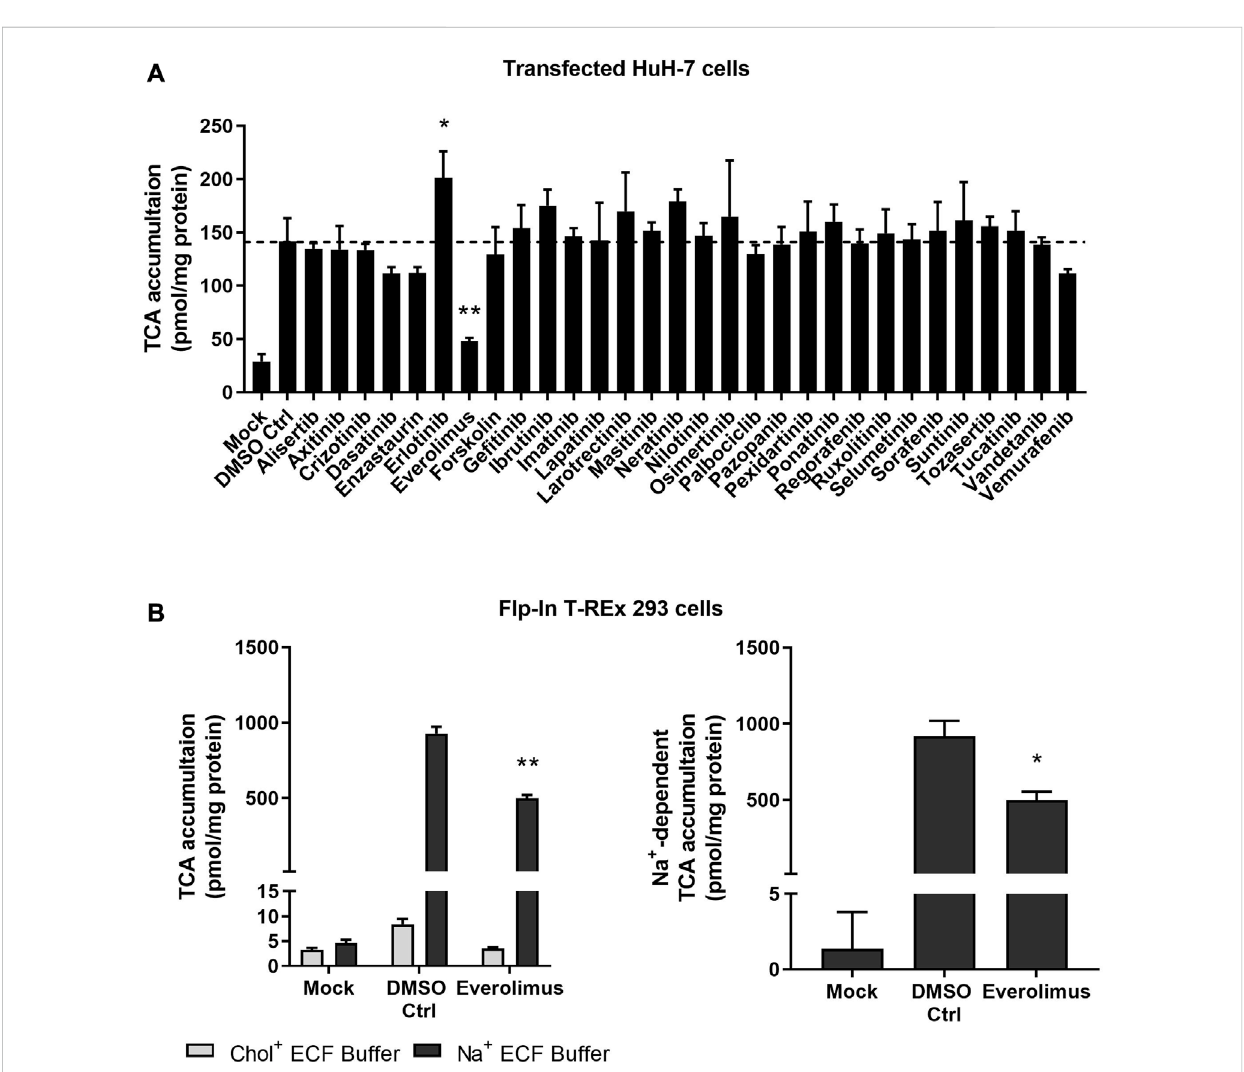
FIGURE 1 EffectofkinaseinhibitorsonNTCP-mediatedtransportoftaurocholate(TCA). (A) Accumulationof[ 3 H]-TCA(2 μ M;200 nCi/mL)inextracellular fl uid buffer(ECF) withNa + over10 minwasmeasuredinMock-GFP-and NTCP-GFP-expressing HuH-7cells inthepresence of0.1%DMSO control orvarious kinase inhibitors (10 µM). NTCP-GFP-expressing HuH-7 cells were pre-incubated for 15 min with 0.1% DMSO control (DMSO Ctrl) or kinase inhibitors (10 µM) in cell culture medium prior to initiation of the accumulation phase. Data were plotted as mean ± SD ( n = 3) and statistically signi fi cant differences compared to DMSO Ctrl were measured using an ordinary one-way ANOVA with Dunnett ’ s multiple comparison test (*, p < 0.05, **, p < 0.0001). (B) Mock-GFP or NTCP-GFP wereinducedin Flp-In ™ T-REx ™ 293 cells with 1 μ g/mL doxycyclinefor three days and NTCP-GFP-expressing Flp- In ™ T-REx ™ 293 cells were pre-incubated with 0.1% DMSO control or 10 µM everolimus for 15 min in cell culture medium prior to initiation of the accumulation phase. Left panel: Accumulation of [ 3 H]-TCA (2 μ M; 200 nCi/mL) in ECF without Na + (Chol + ) or with Na + over 10 min was measured in Mock-GFP- and NTCP-GFP-expressing Flp-In ™ T-REx ™ 293 cells in the presence of 0.1% DMSO control or 10 µM everolimus. Data were plotted as mean ± SEM ( n = 3, in triplicate) Right panel: Na + -dependent [ 3 H]-TCA accumulation was calculated based on the data in the left panel by subtracting [ 3 H]-TCA accumulation in Chol + buffer from [ 3 H]-TCA accumulation in Na + buffer. Data were plotted as mean ± SEM ( n = 3, in triplicate). Statistically signi fi cant differences compared to DMSO Ctrl were measured using an ordinary two-way ANOVA with Dunnett ’ s multiple comparison test (**, p < 0.0001; left panel) or an unpaired two-tailed t -test (*, p < 0.01; right